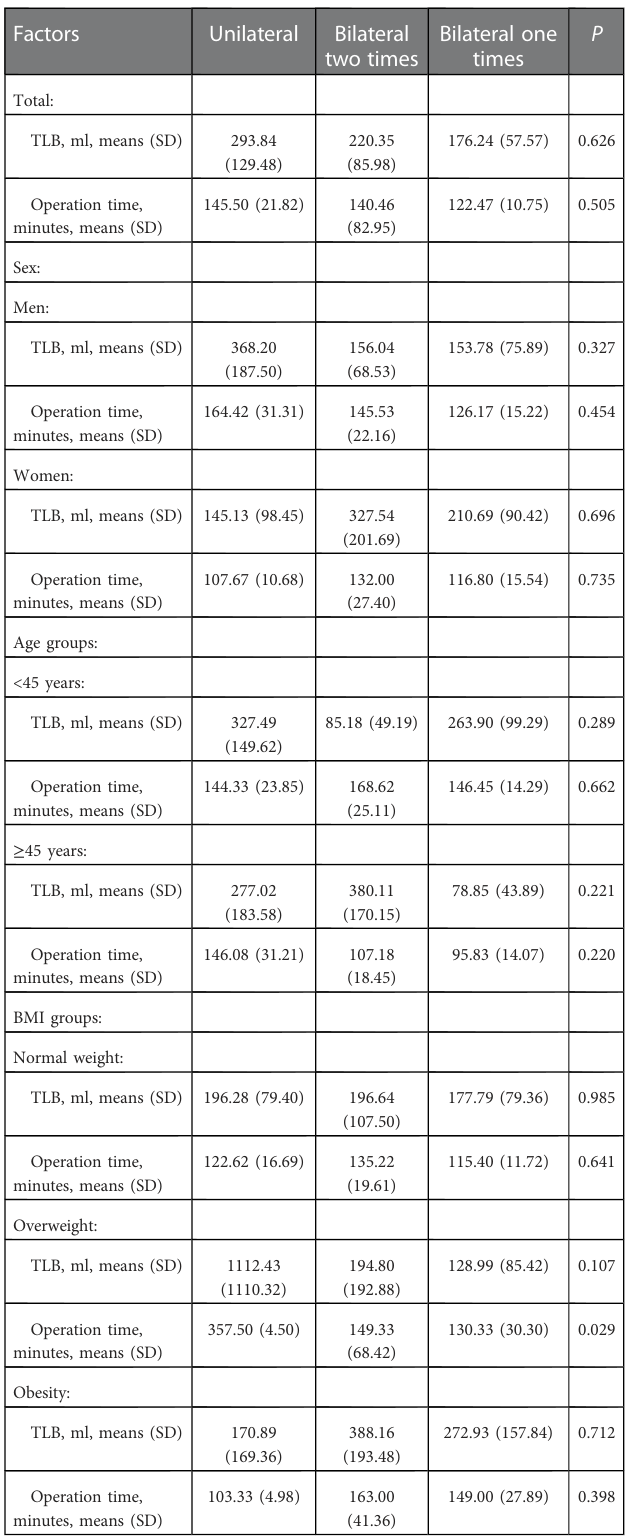
TABLE 3 The security evaluation among patients in unilateral, bilateral two times, and bilateral one time.